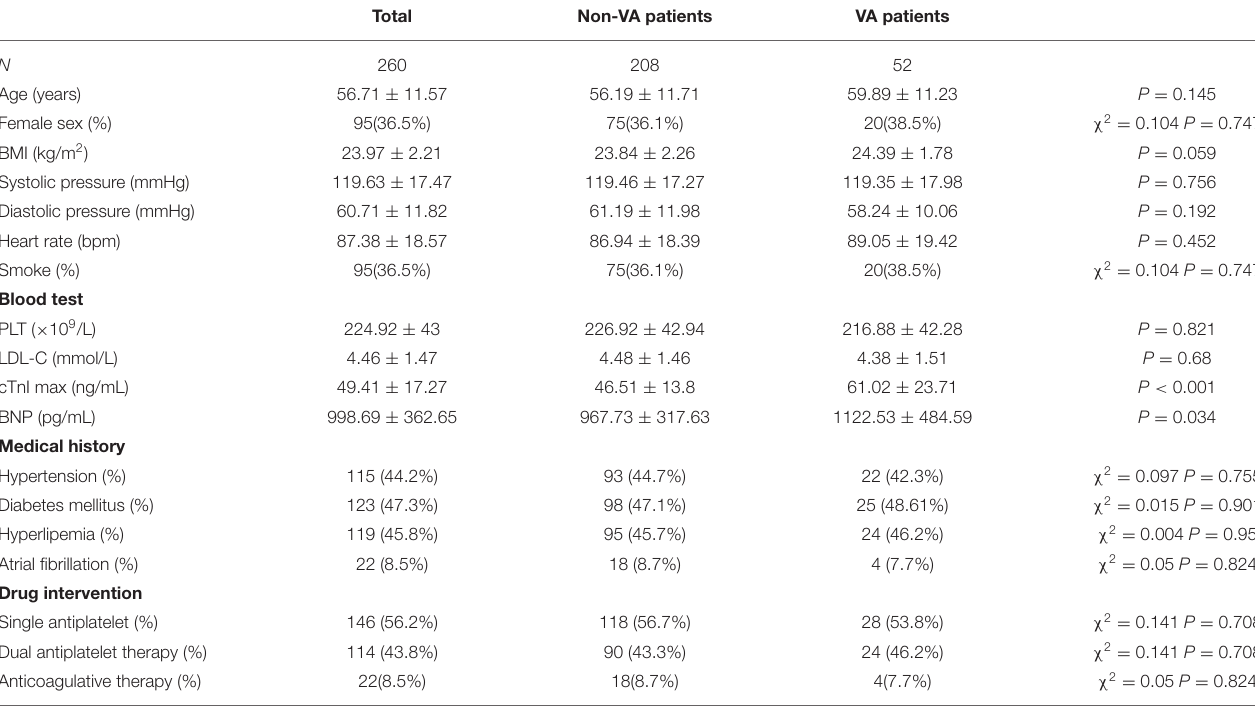
TABLE 1 | Baseline characteristics compared between patients with and without VA.